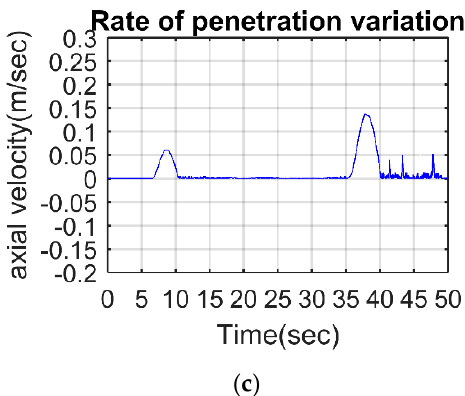
Figure 12. Results of system responses for fifth scenario: ( a ) angular velocities, ( b ) Tob, ( c ) ROP.